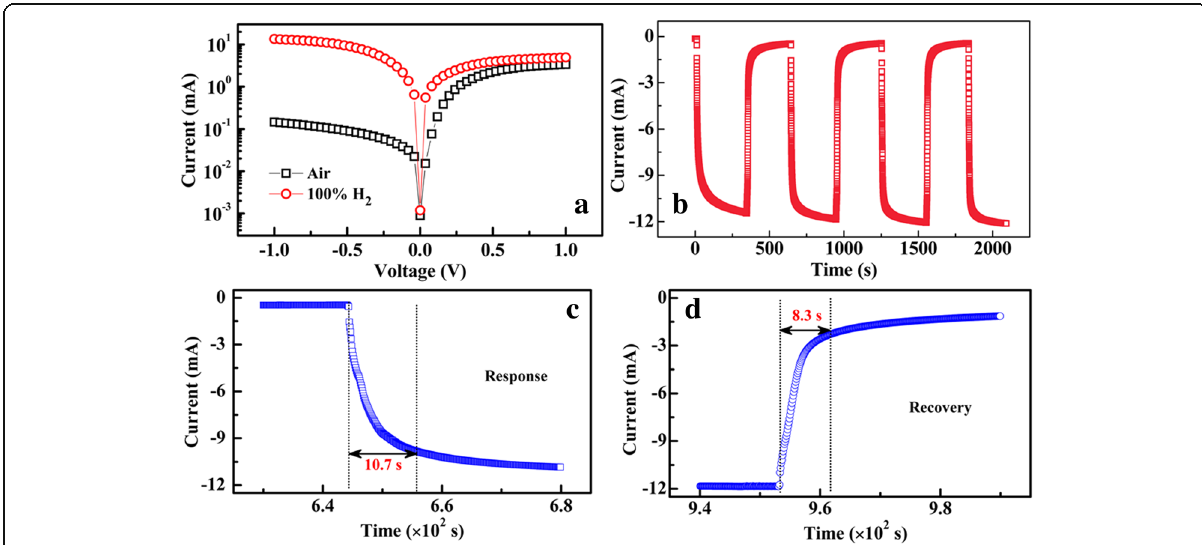
Fig. 5 a LgI~V curves of the Pd-decorated MoS 2 /Si heterojunction. b I vs t graphs of the Pd-decorated MoS 2 /Si heterojunction exposed to pure H 2 at − 1.0 V and RT. c , d Enlarged response and recovery edges, respectively, of the sensing curve. The response time ( t res ) is the time interval for the response to rise from 10 to 90% of the total current change. The recovery time ( t rec ) is the time interval for the response to decay from 90 to 10% of the total current